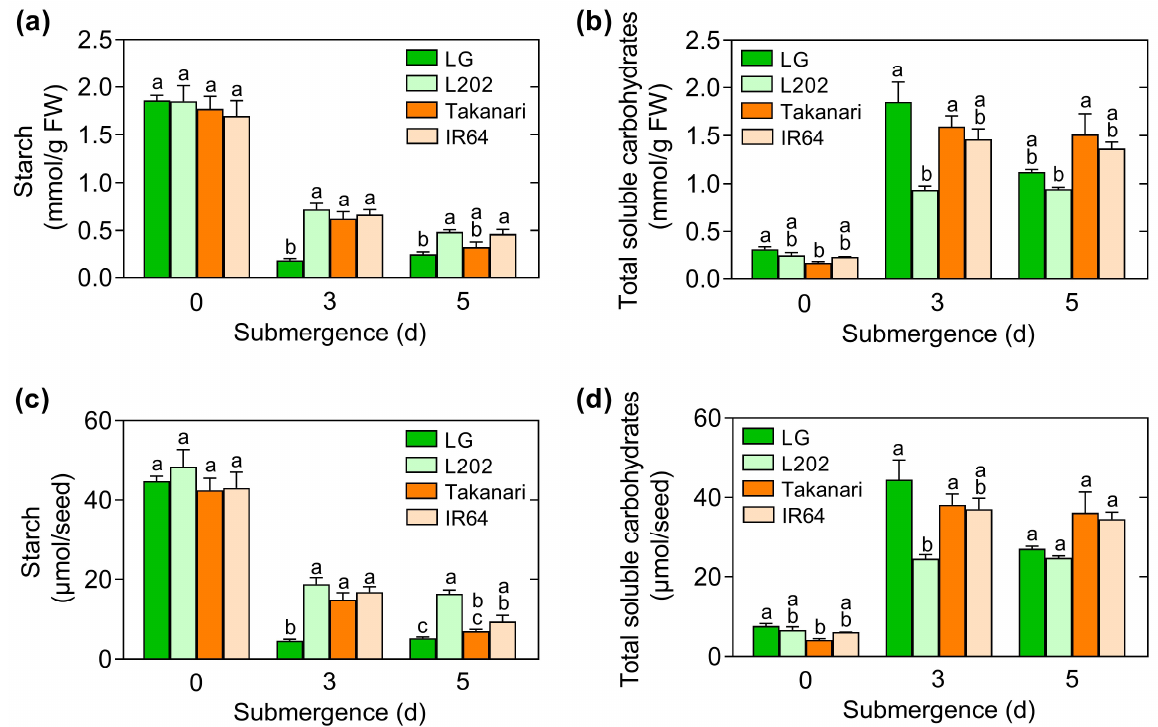
Figure 4. Starch breakdown and soluble carbohydrate accumulation in anaerobically germinating seeds. Seeds were incubated under 12 h light and 12 h dark cycles for up to 5 days under oxygen deprivation. The concentrations of starch ( a , c ) and total soluble carbohydrates ( b , d ) in seeds or seedlings were quantified on days 0, 3, and 5. In ( a ) and ( c ), the concentrations were calculated on a per g fresh weight (FW) basis. In ( b ) and ( d ), the concentrations were determined on a per seed basis. Data represent means ± SE ( n = 3). Multiple comparisons of means were performed using ANOVA followed by Tukey’s honest significant test. Bars not sharing the same le(cid:308)er are significantly differ- ent at each time point ( p < 0.05).